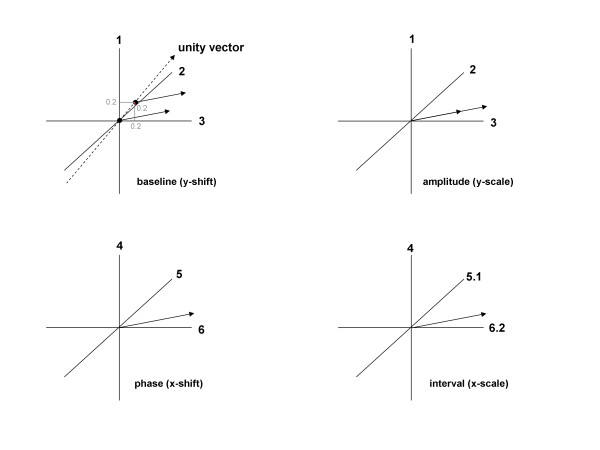
Differences in extrinsic features of signal space, shown as graphs.